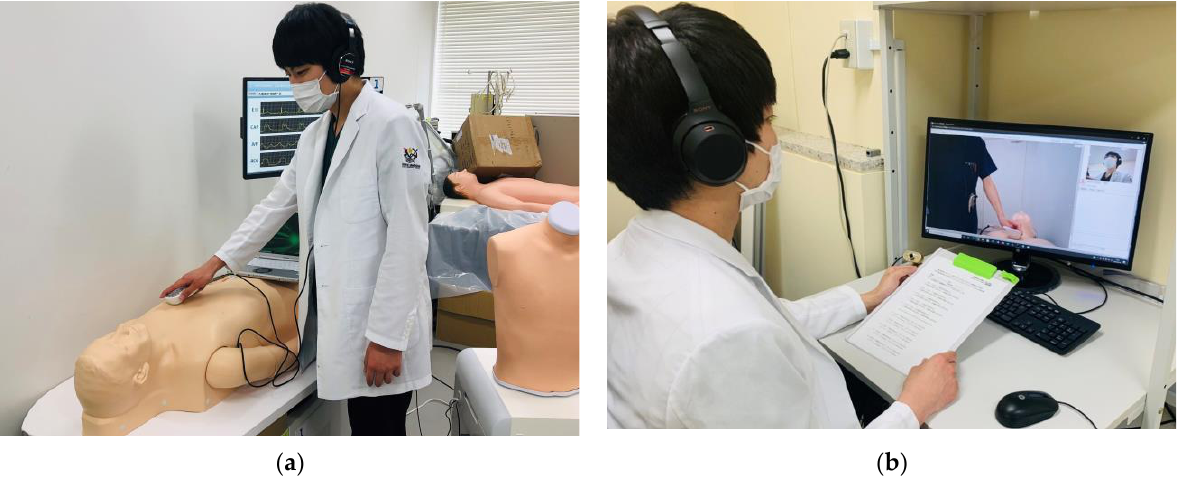
Figure 3. The internet-connected real-time remote auscultation processes. ( a ) The researcher puts an electronic stethoscope on the simulator. ( b ) The participant remotely auscultates the sound with an internet-connected medical system.